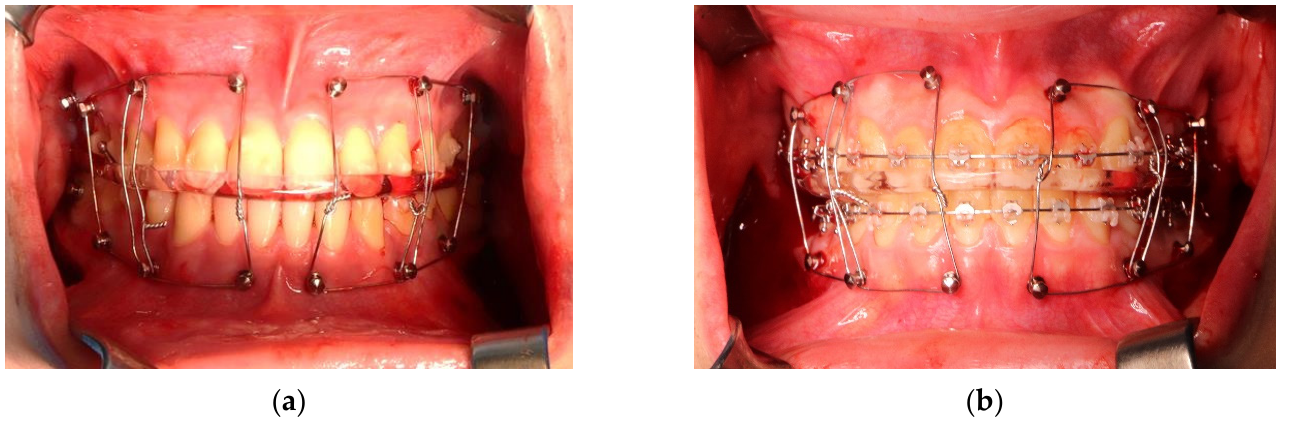
Figure 10. ( a ) Intraoperative clinical picture of orthognathic surgery patient with clear aligners. This photo shows the maxillomandibular fixation using wire as a final occlusion state after three mini screws were placed in each segment before fixing the miniplate to the mandible. There are no fixed braces or metal wires attached to the teeth. ( b ) Clinical pictures of patients who received orthodontic treatment with brackets. The photographing method is the same as in ( a ).